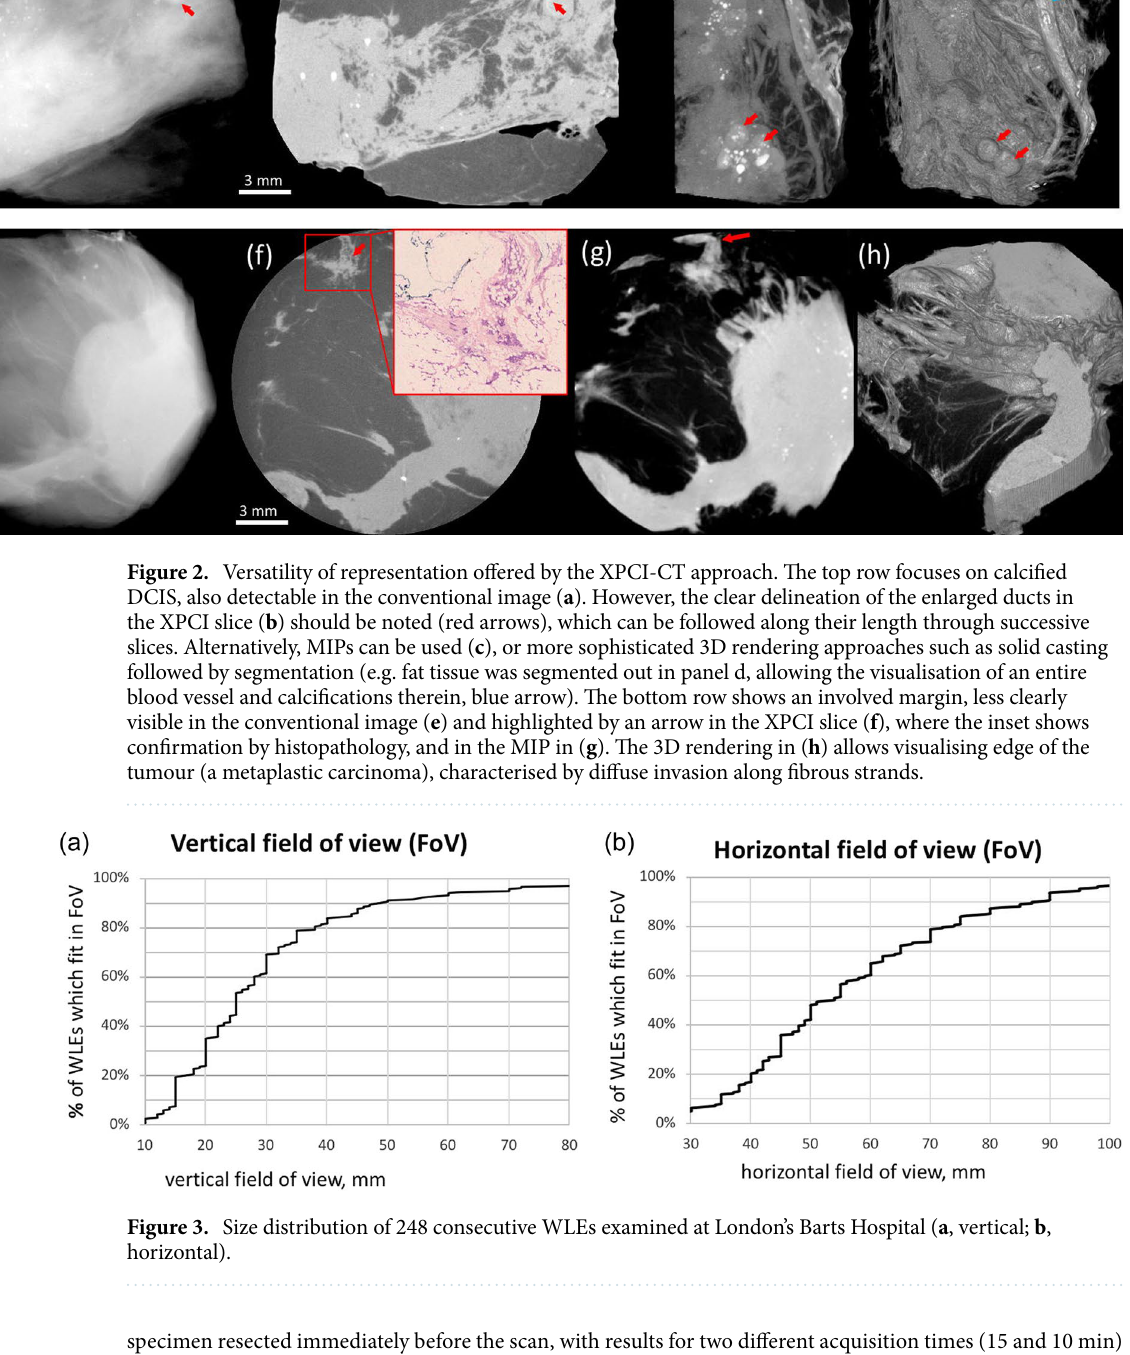
specimen resected immediately before the scan, with results for two different acquisition times (15 and 10 min) shown in Fig. 4. Albeit a grainier texture, resulting from the combination of faster scans and thicker samples, becomes appar- ent in the zoomed-up regions of interest, all key image features remain visible, despite the larger specimen size and scan times being reduced to a level compatible with intraoperative use. Notably, image quality is only marginally affected when the scan time is reduced from 15 to 10 min, indicating the possibility for additional reductions, which will be explored in a dedicated study. Image reconstruction took an additional 10–15 min (on a 24-core PC), however this was not optimised yet at this stage.